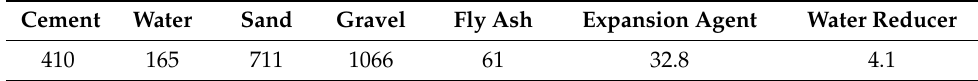
Table 1. Concrete proportioning parameters (kg/m 3